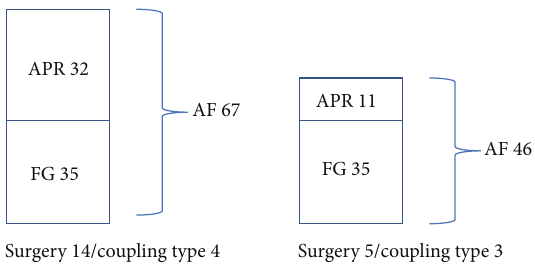
Figure 8: Exemplar estimation of the AF for surgeries 5 and 14 with the specific information attached.